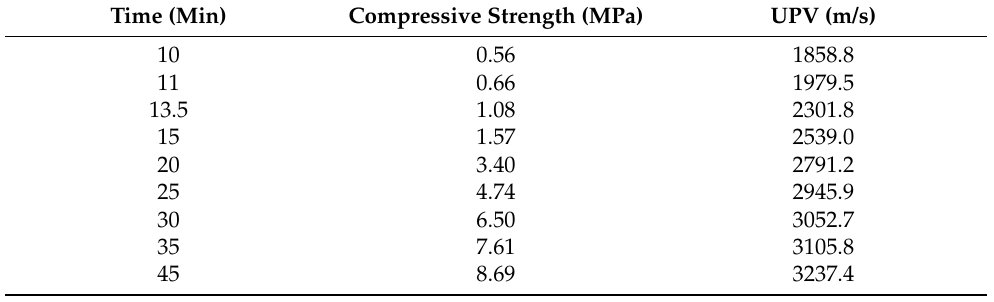
Table 3. Experimental compressive strength values of mix 2 with their corresponding UPV values.